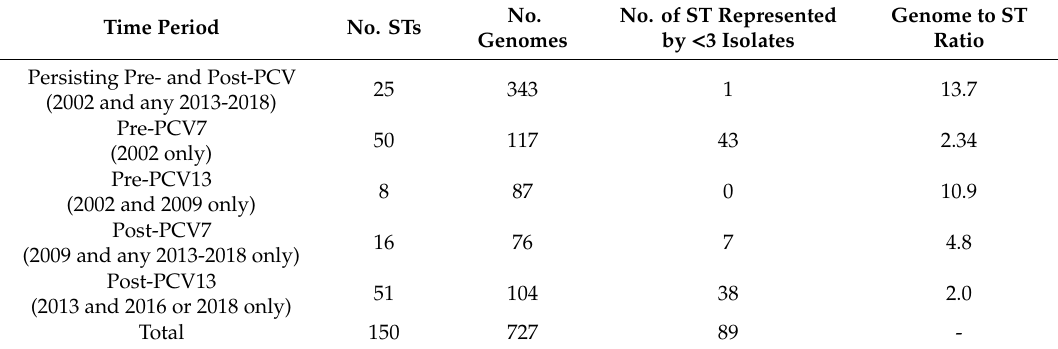
Table 2. Number of Sequence types (STs) unique to each period of the carriage studies and the number of genomes represented by these STs. The ratio of genomes to STs is included to show the diversity of the genomes.